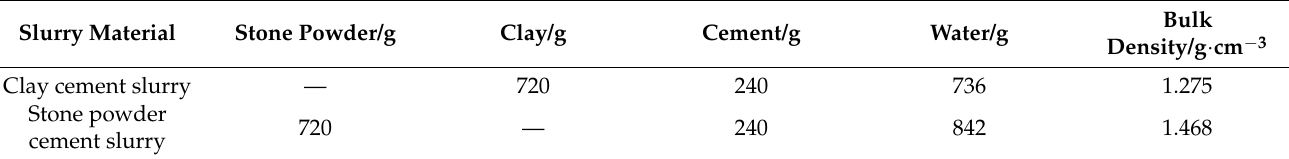
Table 7. Slurry material mix ratio.